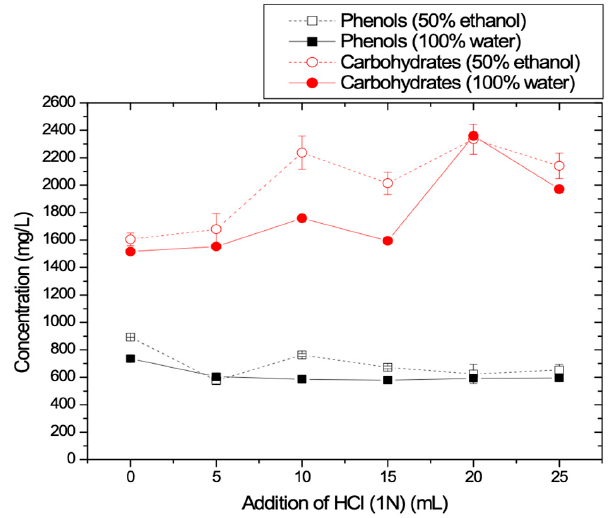
Figure 4. TPC and carbohydrates concentrations as a function of added HCl (1N).